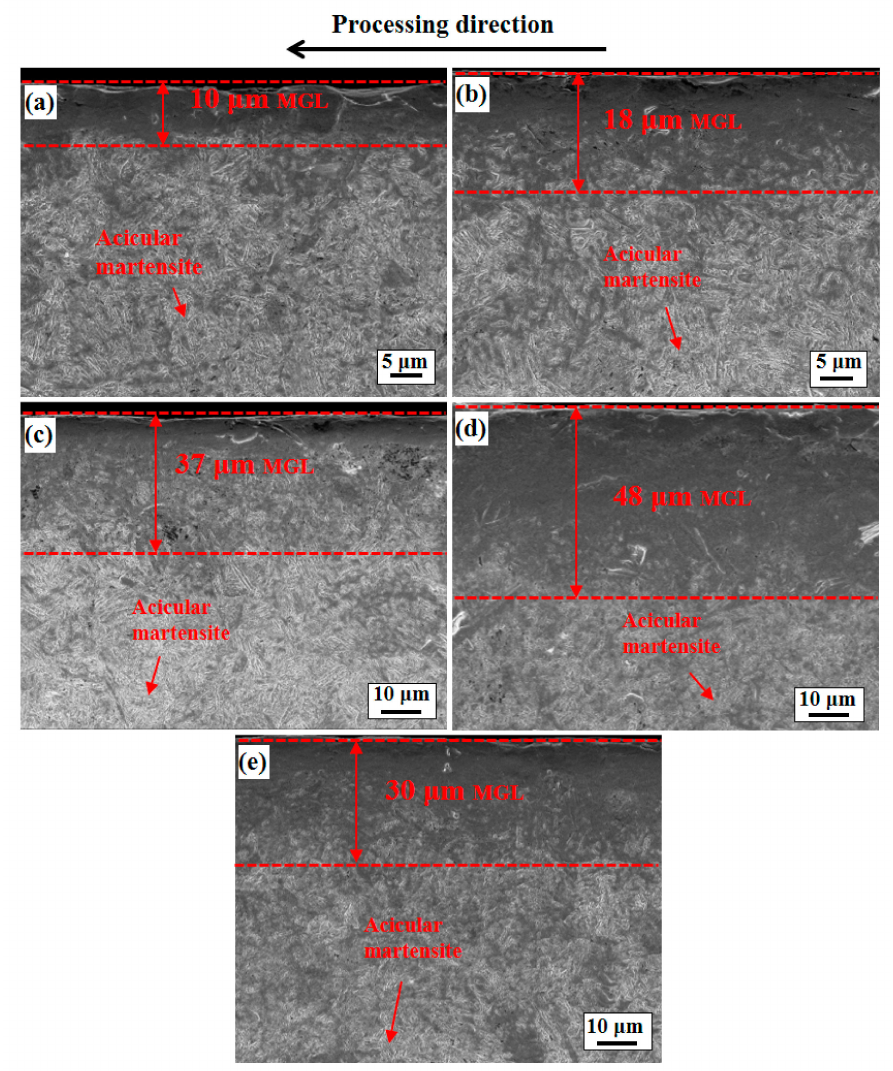
Figure 3. Longitudinal section SEM images of 51CrV4 spring steel specimens under five processes: ( a ) U3.4-1, ( b ) U3.4-2, ( c ) U3.4-3, ( d ) U6.3 and ( e )